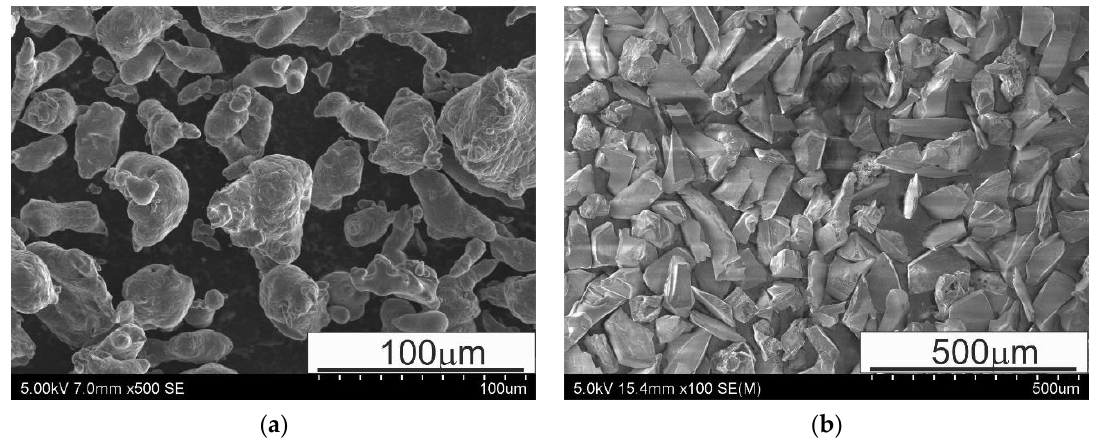
Figure 1. SEM micrographs of powders: ( a ) Al (<63 µm) and ( b ) SiC (60–80 µm); SEM.